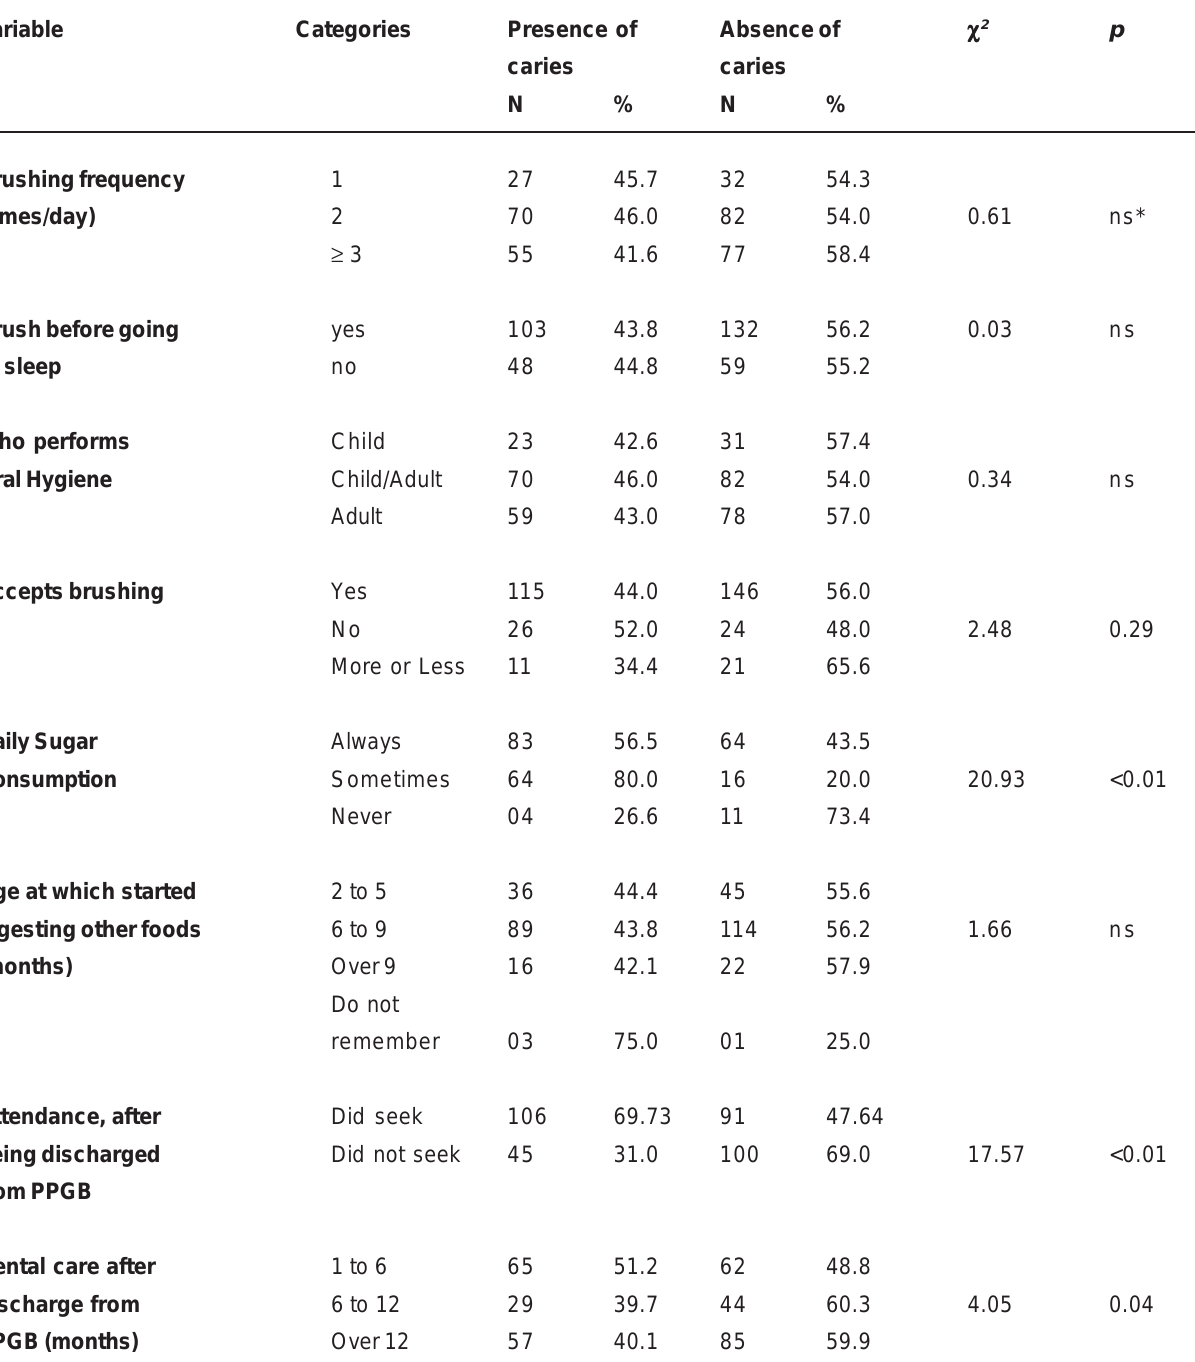
TABLE 4- The Chi-square test ( χ 2 ) and the p values for behavioral variables according to the presence or absence of dental caries, Federal University of Piauí,